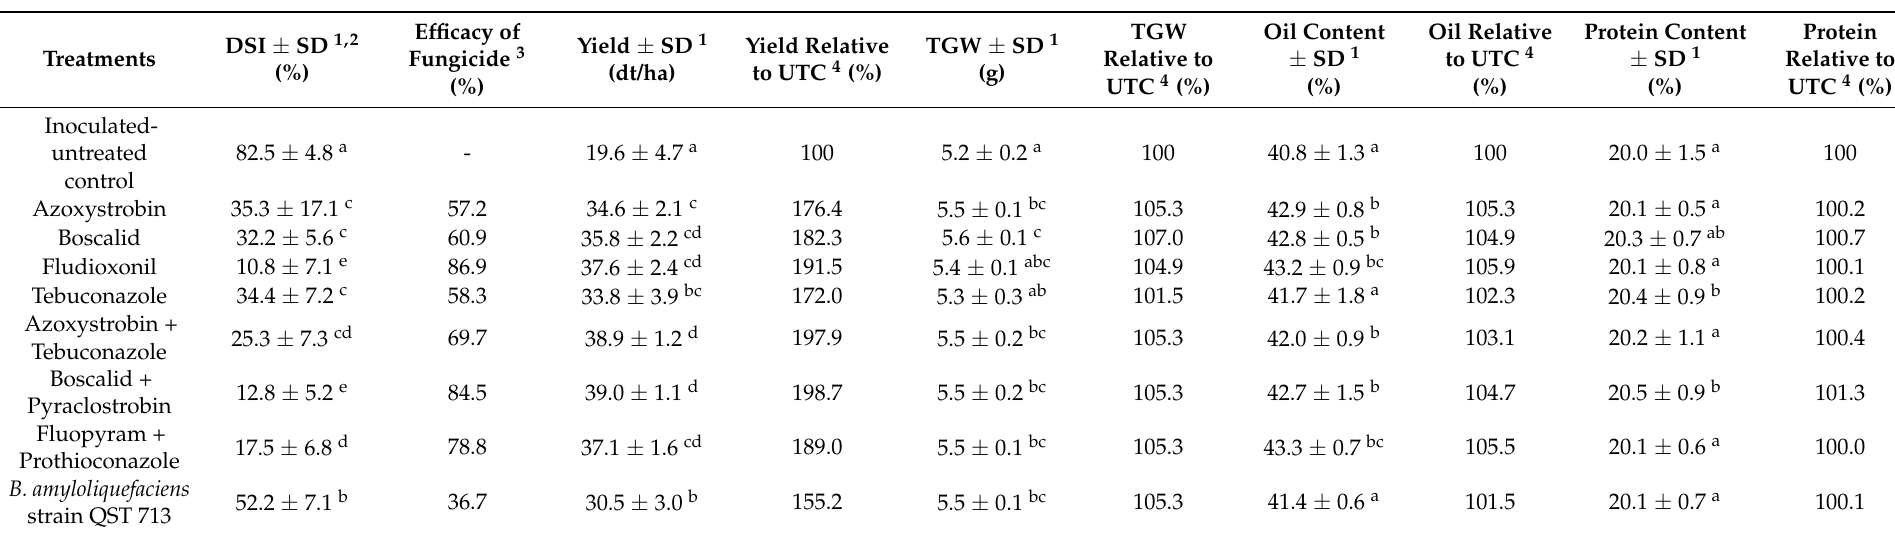
Table 2. Effect of various group of fungicides as well as a biopesticide in controlling Sclerotinia stem rot in oilseed rape cultivation under field conditions.